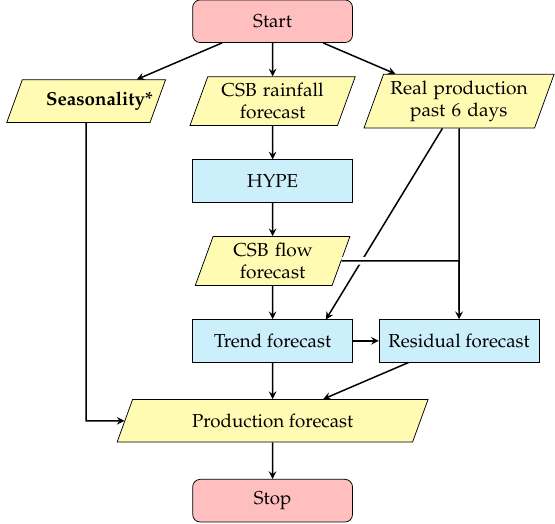
Figure 4. Hybrid ANN forecast flow chart; CSB stands for Correlated